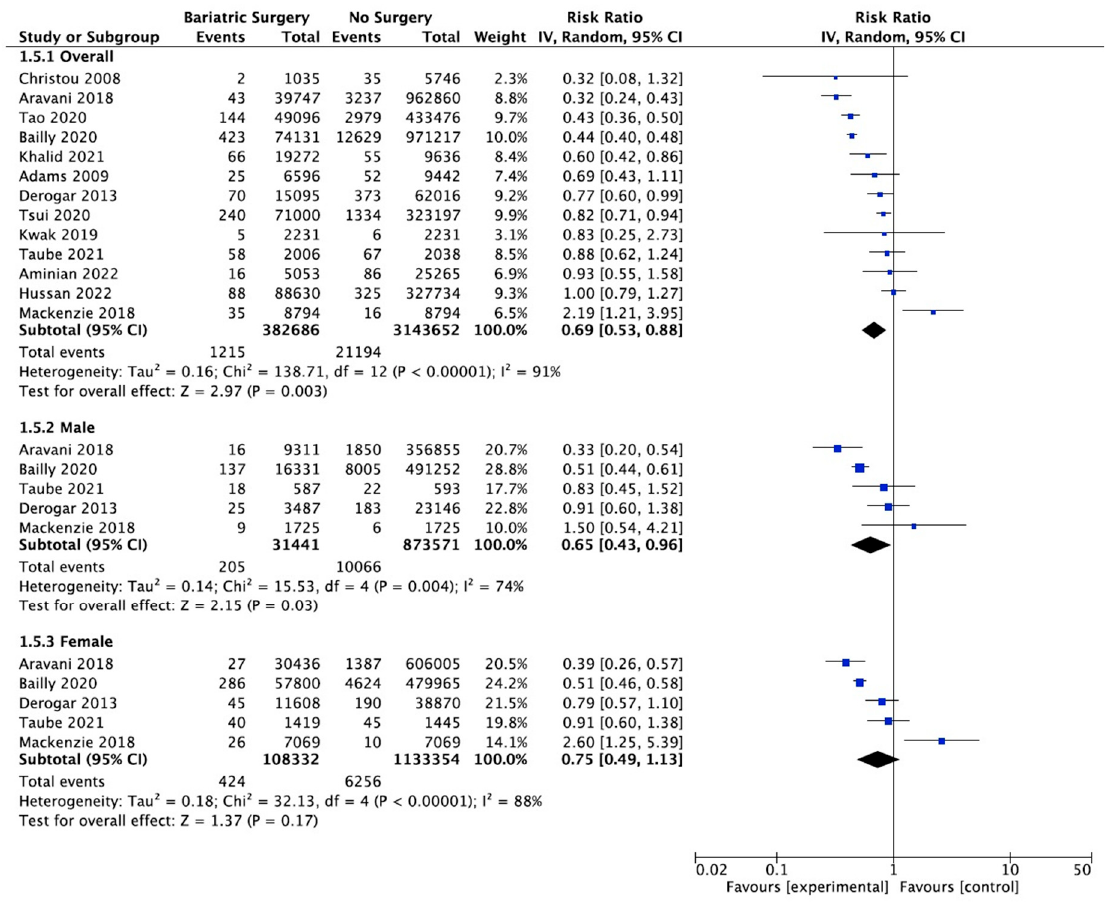
Figure 9. Colorectal cancer incidence [38,40,42,43,45,49,50,58–63].